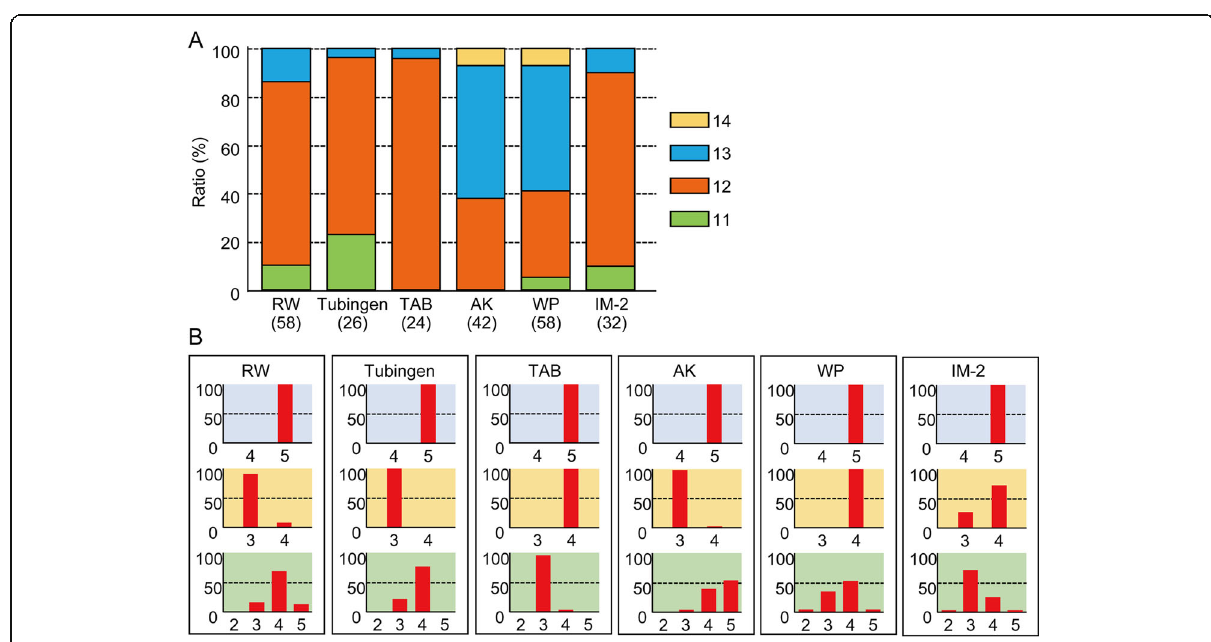
Fig. 3 Variation in the number of fin rays within the three domains of the pectoral fin of zebrafish strains. a Proportion of specimens with different numbers of fin rays among the zebrafish strains. The number of specimens analyzed is indicated under the strain ’ s name. b Relationships between the number of fin rays and fin domains. Graphs colored light blue, orange, and green are in the anterior (dr1 – 5), middle (dr6, 7), and posterior (dr8) domains. Numbers on the vertical axis of graphs indicate the ratio (%) of the distribution of specimens. Numbers on the lateral axis indicate the number of fin rays in the domains. Red bars indicate the ratio of specimens to the number of fin